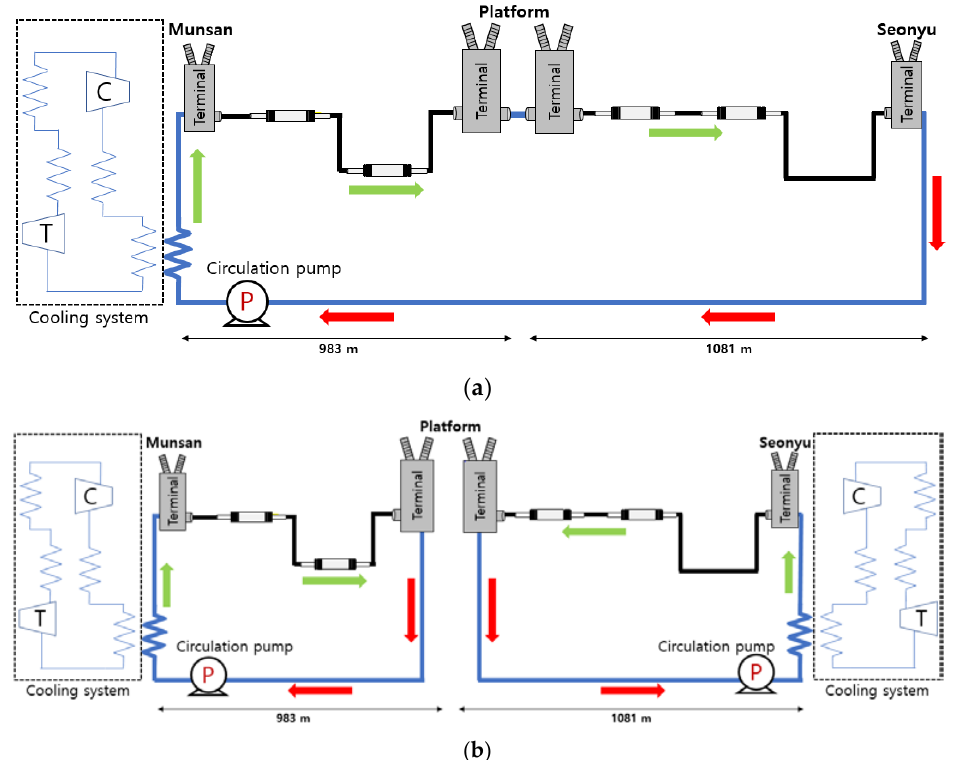
Figure 5. Configurations of cooling system with an external return path: ( a ) single cooling system at Munsan; ( b ) dual cooling system.